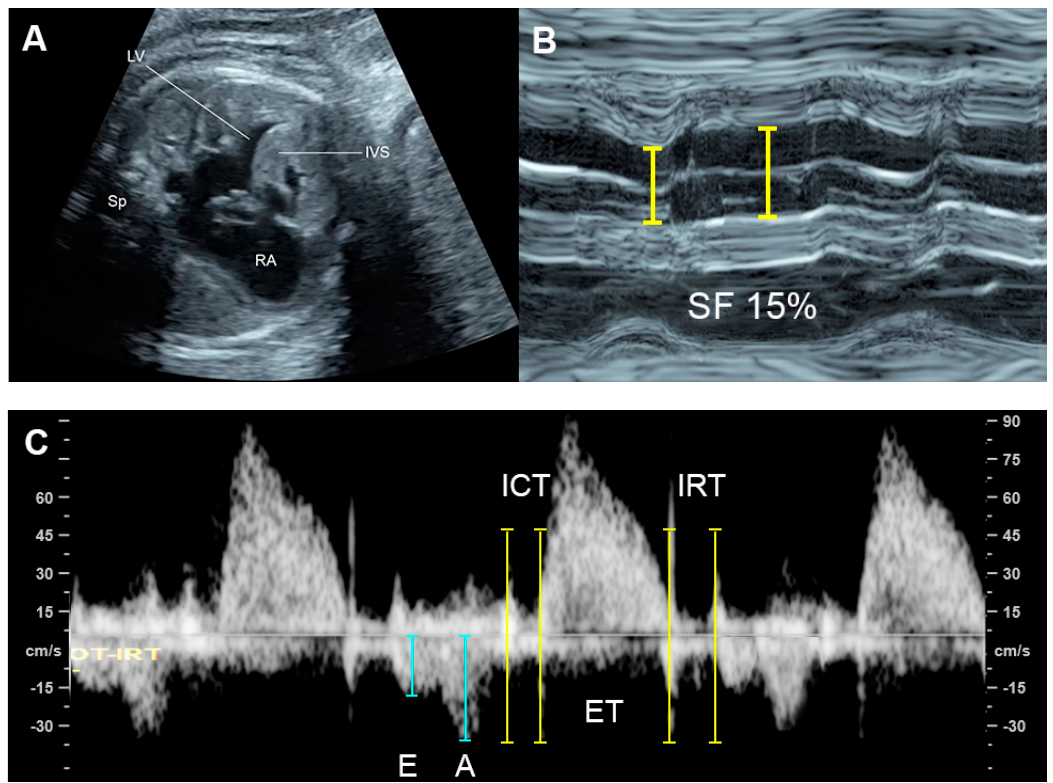
Figure 9. Hypertrophic cardiomyopathy: ( A ) four-chamber view: thickened ventricular wall and interventricular septum; ( B ) M-mode: poor contractility with a shortening fraction of 15%; ( C ) Car- diac PW Doppler: Low E/A ratio, prolonged IRT and increased Tei index (ICT: 40 ms; ET 154 ms; IRT 54